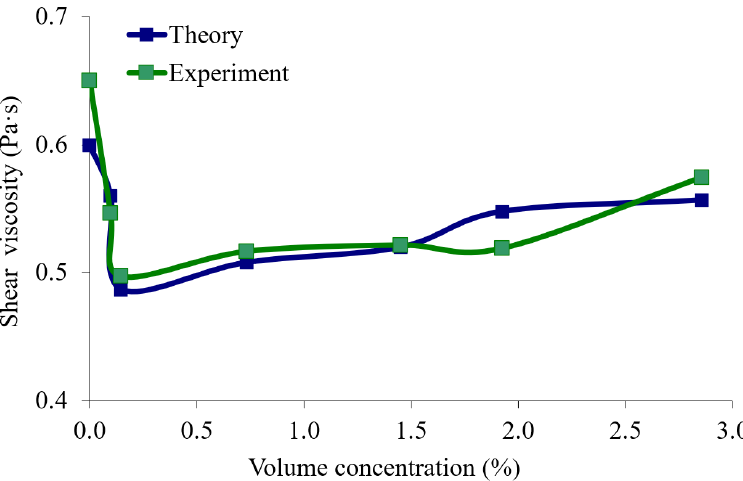
Figure 10. The dependence of the shear viscosity coefficient of the suspension on the volume concentration of the diamond particles. The data obtained by the resonator (blue color) and by the viscometer (green color).